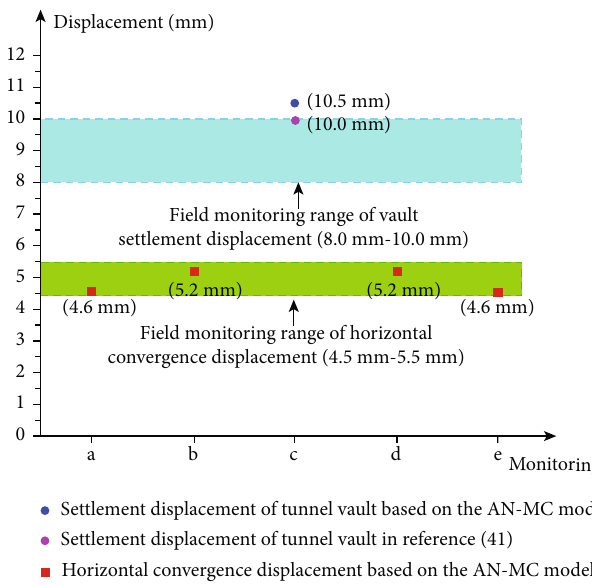
Figure 6: Displacement comparison of monitoring